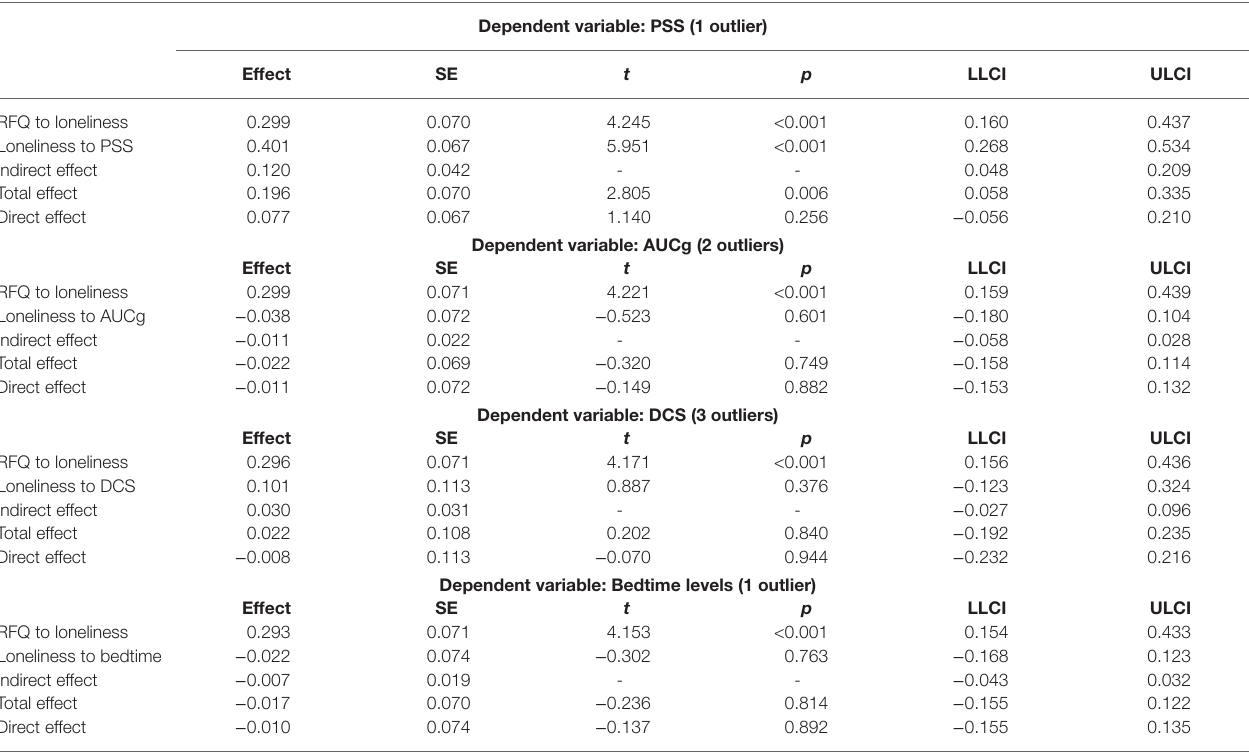
TABLE 4 | Adjusted mediation models of the relationship between ELS (measured by RFQ) as predictor and perceived stress and cortisol levels (AUCg, DCS, and bedtime) as dependent variables via